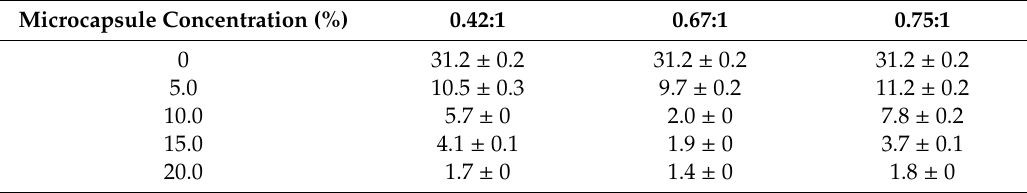
Table 6. Effect of microcapsule concentration (0.42:1, 0.67:1, and 0.75:1 core-wall ratios) on 60° gloss. Microcapsule Concentration (%)